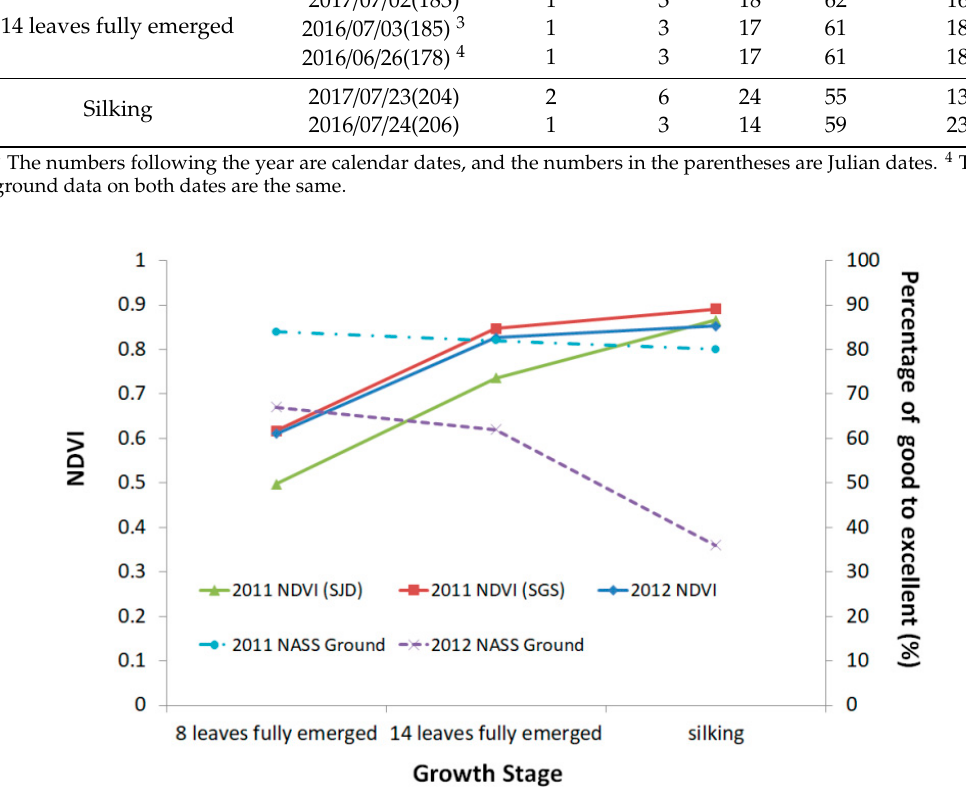
Figure 10. The 2012 NDVIs at SGS and 2011 NDVIs at SGS and SJD and corresponding NASS reported data for validation. The x-axis represents 2012 growth stage (with Julian date). The 2011 NDVIs at SGS and SJD are in red and green solid lines respectively. They are aligned with 2012 growth stages and Julian day respectively. The 2012 NDVI at SGS is in blue solid line. The 2012 NASS reported percentage of crop in good and excellent categories (in purple dashed line) is lower than the corresponding 2011 NASS reported data (in light blue dash dot line). Obviously, the results based on SJD NDVI (green solid line) are not consistent with the NASS reported crop condition data.